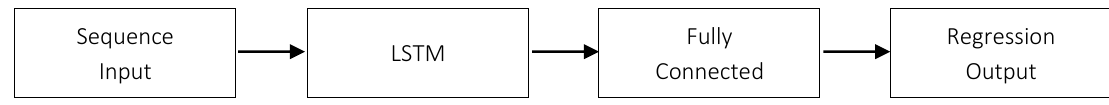
Figure 2. Simple LSTM